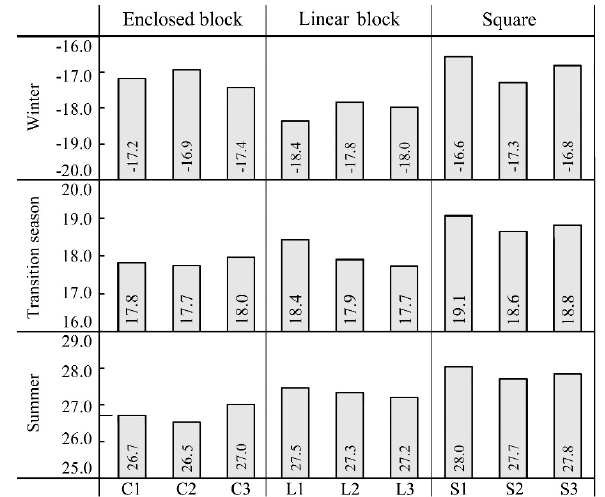
◦ C) of each measurement point in di ff erent Figure 9. Average air temperature ( ℃ ) of each measurement point in different seasons. Figure 9. Average air temperature (